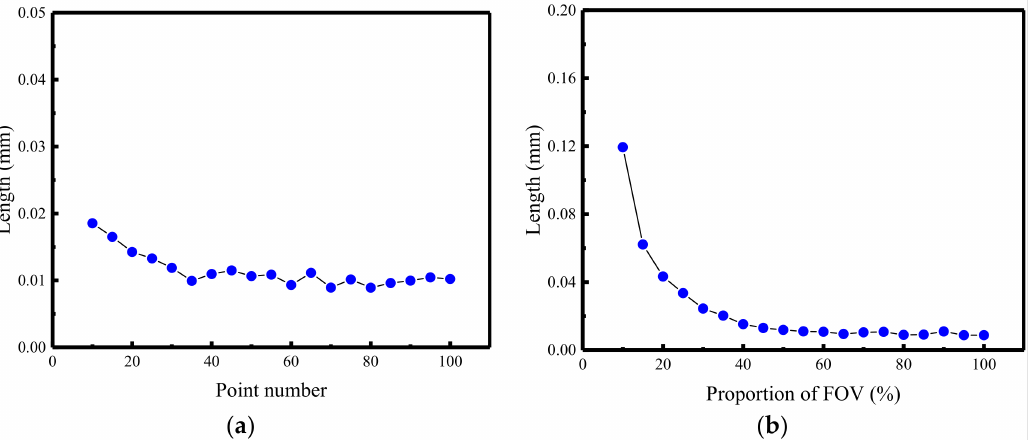
Figure 8. The influence of feature point factors: ( a ) the number of feature points; ( b ) the proportion of the FOV occupied by the feature